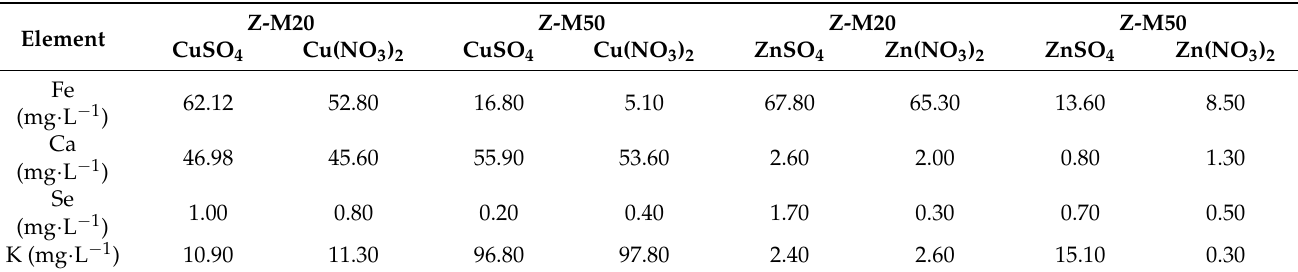
Table 9. The concentration of elements in posttreatment solution.